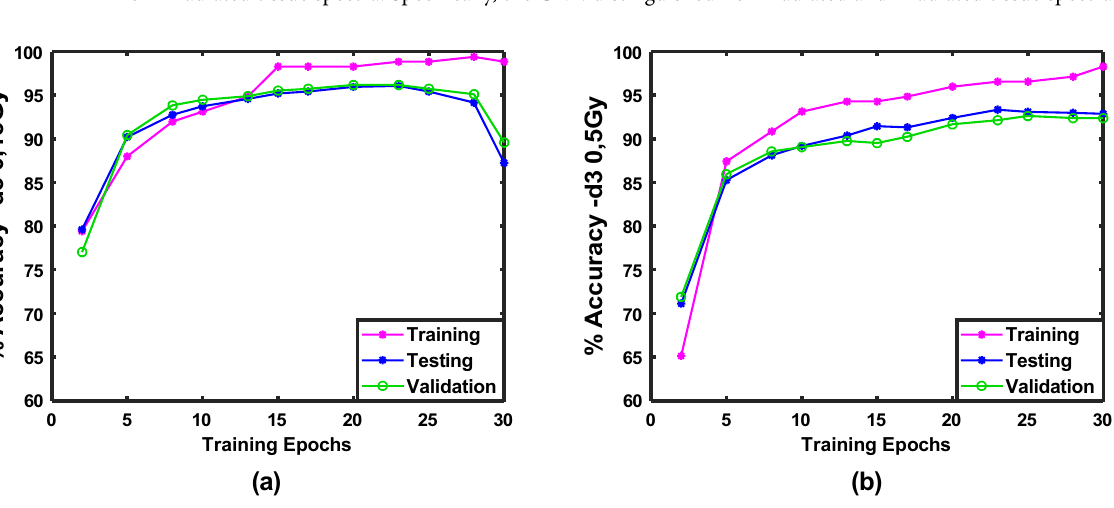
Figure 6. Training (magenta), testing (blue), and validation (green) accuracies plotted against number of training epochs for one run of the CNN model on ( a ) Day 3, 0 and 15 Gy and ( b ) Day 3, 0 and 5 Gy treatment